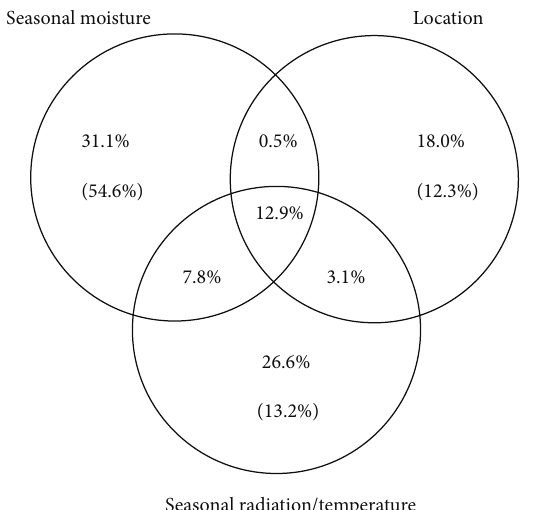
Figure 3: Proportion of explained variation in hollow number within three major groups (values in brackets are those obtained from plot values extrapolated to hectares). Values are percentages of explained variation of the full model (14.1%